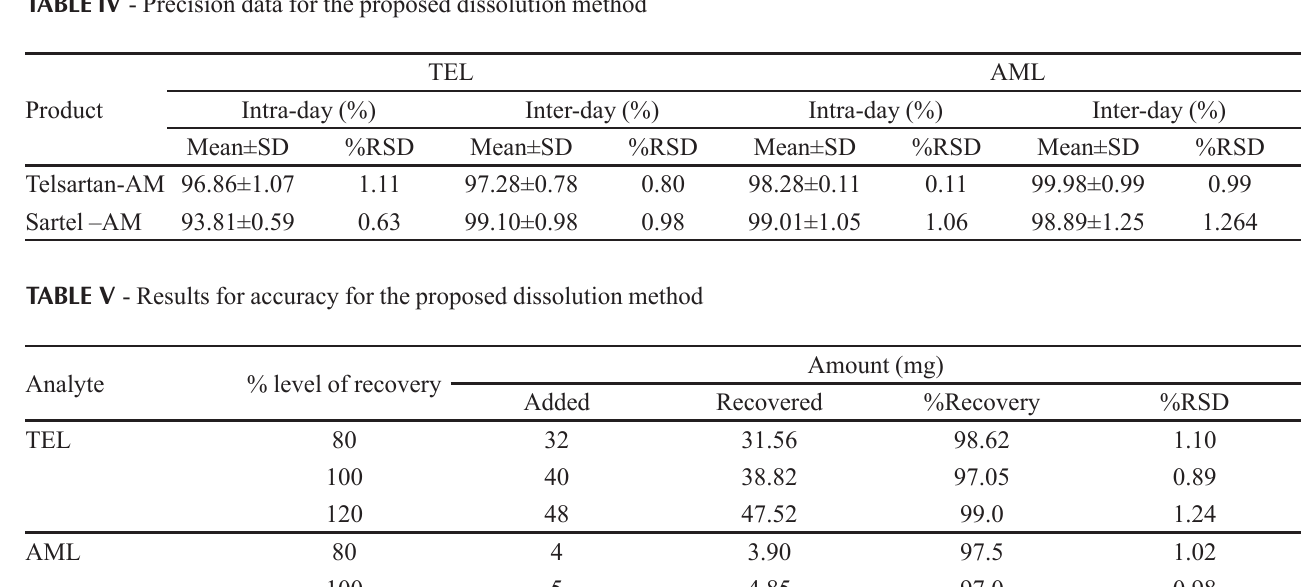
TABLE IV - Precision data for the proposed dissolution method